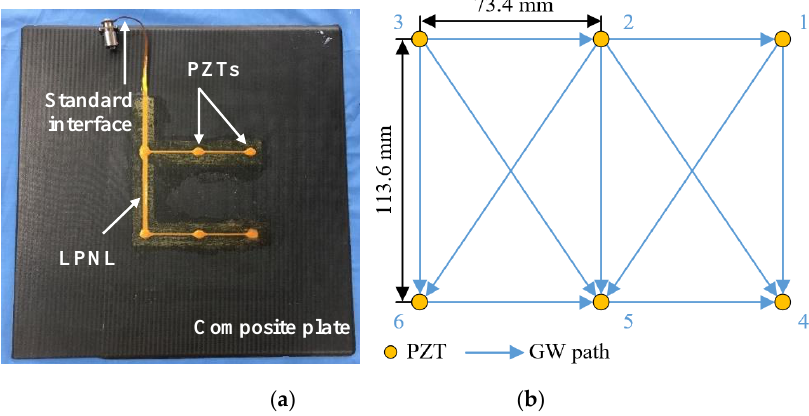
Figure 3. The adopted LPNL and its placement. ( a )The surface mounted LPNL, ( b ) Placement of the PZT network.